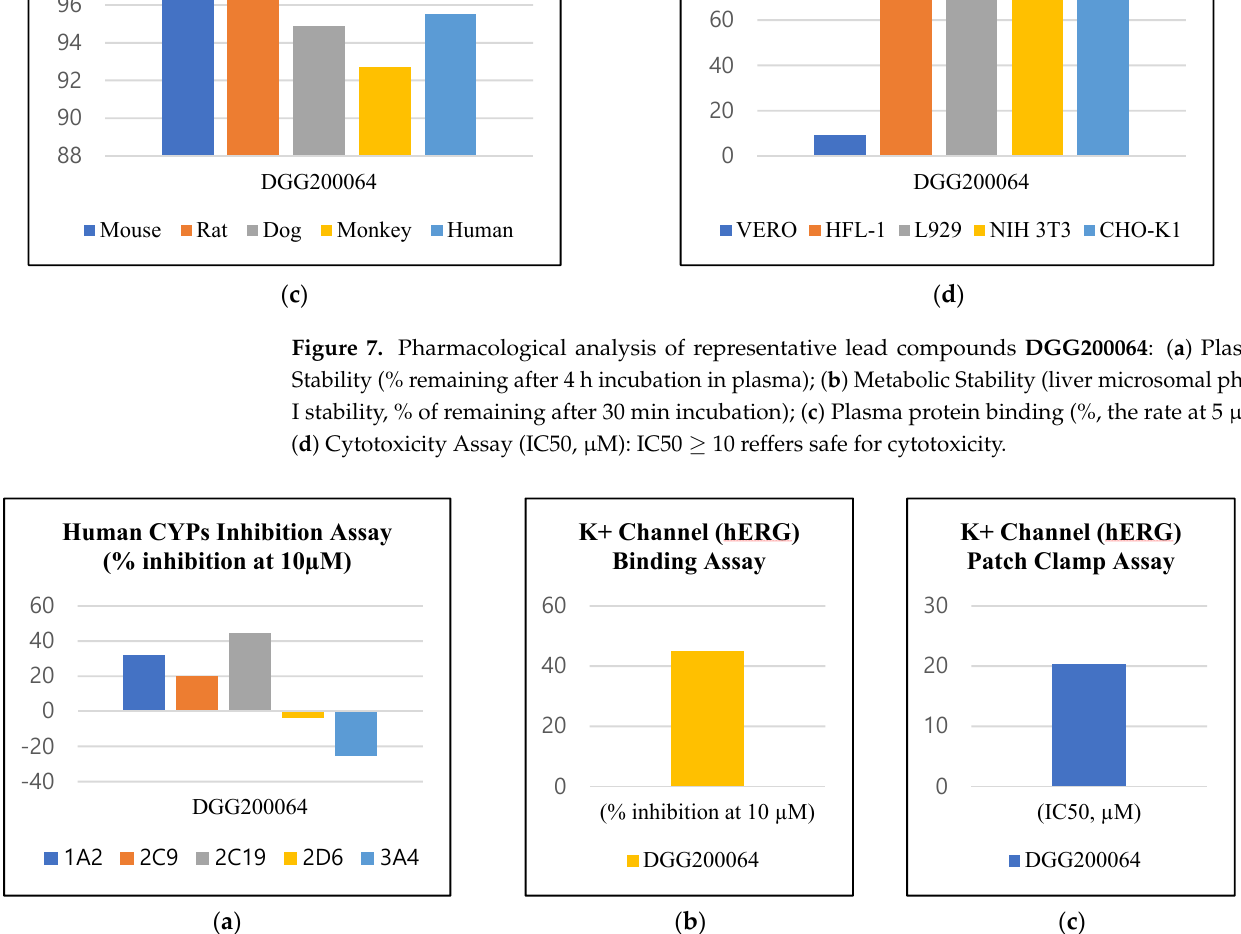
Figure 8. Inhibition analysis of lead compounds DGG200064 : ( a ) Human CYPs inhibition assay (% inhibition at 10 μ M); ( b ) K+ Channel (hERG) binding assay: % inhibition ≤ 50 means safe for hERG channel inhibition; ( c ) K+ Channel (hERG) Patch Clamp assay: IC50 ≥ 10 means safe for hERG chan- nel inhibition.